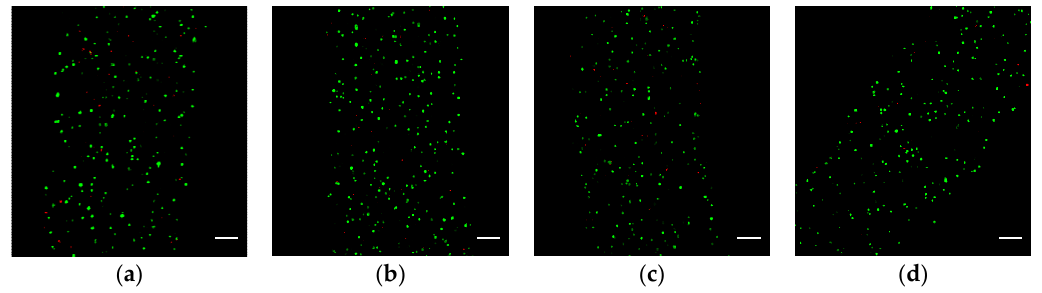
Figure 5. Fluorescence images showing the distribution of LIVE/DEAD cells in the hydrogel fibers after 24 h of culturing : ( a – d ) are the four samples soaked in the Ca 2+ bath for 0, 5, 10, and 15 min, respectively. The green and red dots represent the live and dead cells, respectively; the scale bar is 100 μ m.